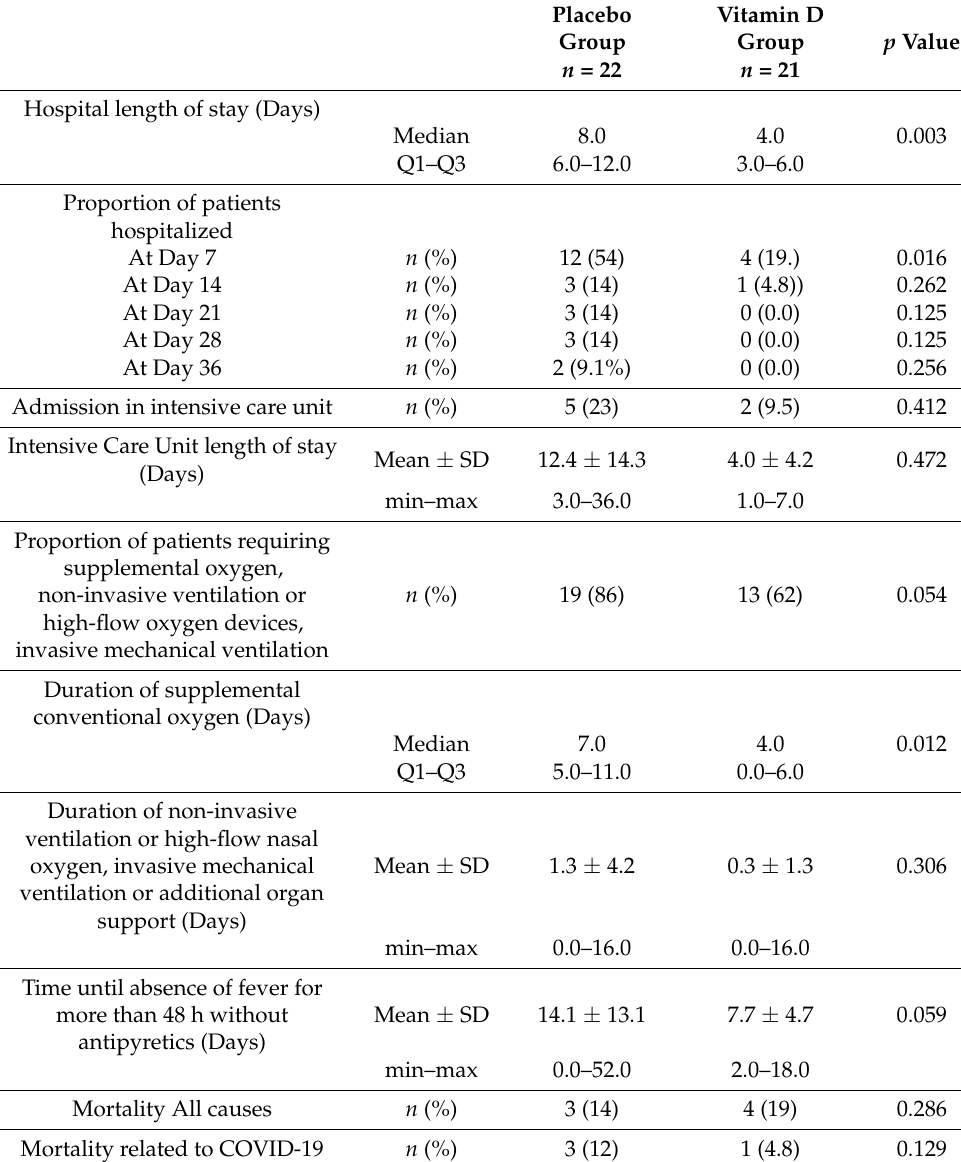
Table 3. Clinical